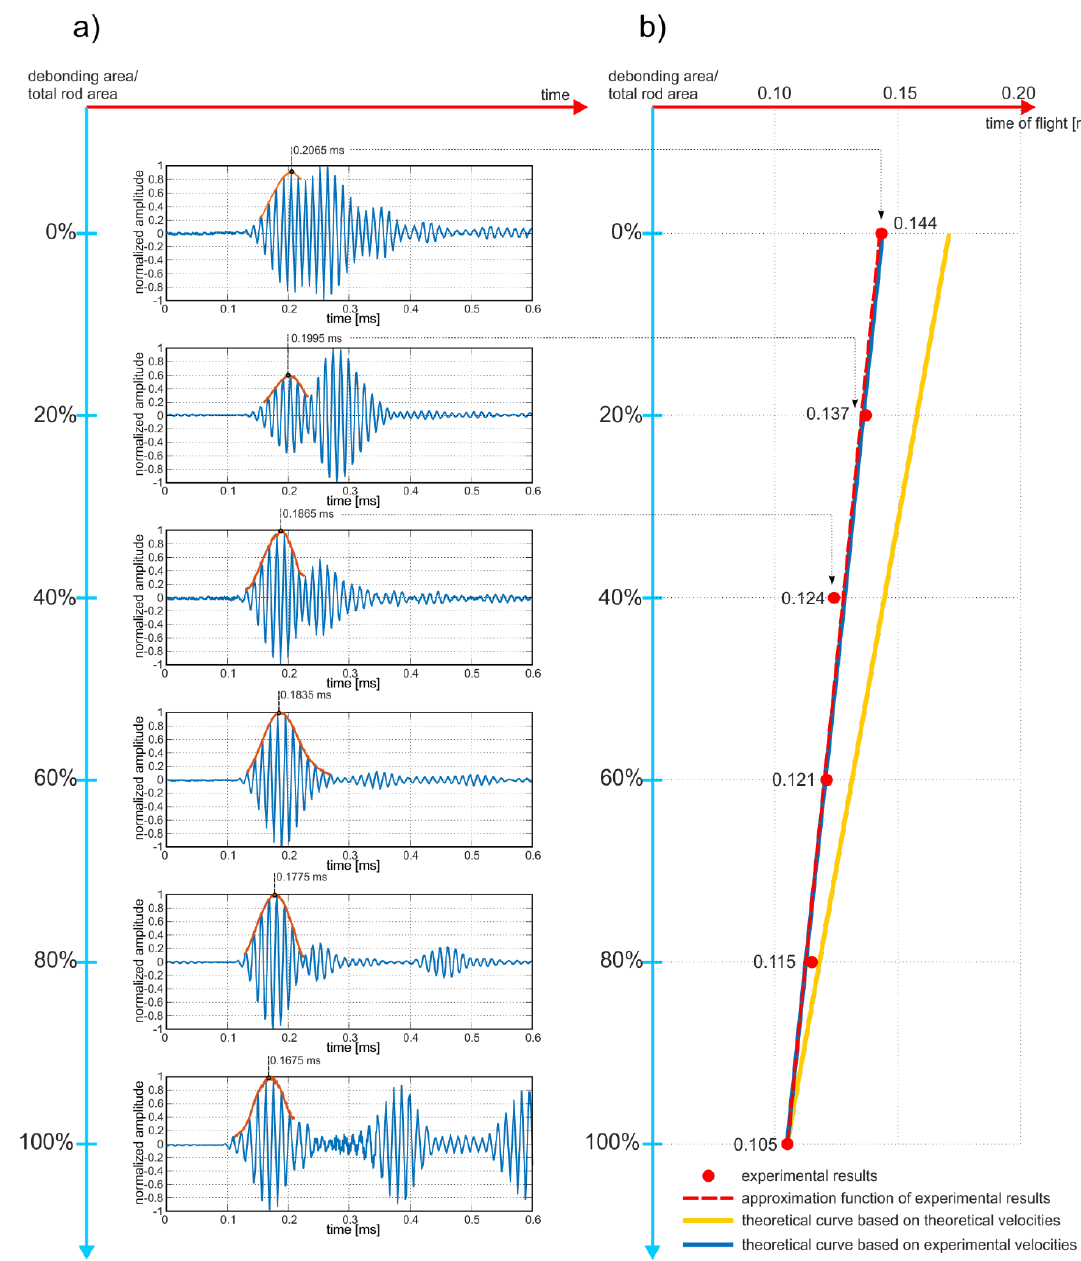
Figure 10. Results of experimental investigations: ( a ) Time-domain signals registered at the end of the beam, ( b ) values of the ToF for varying debonding areas.